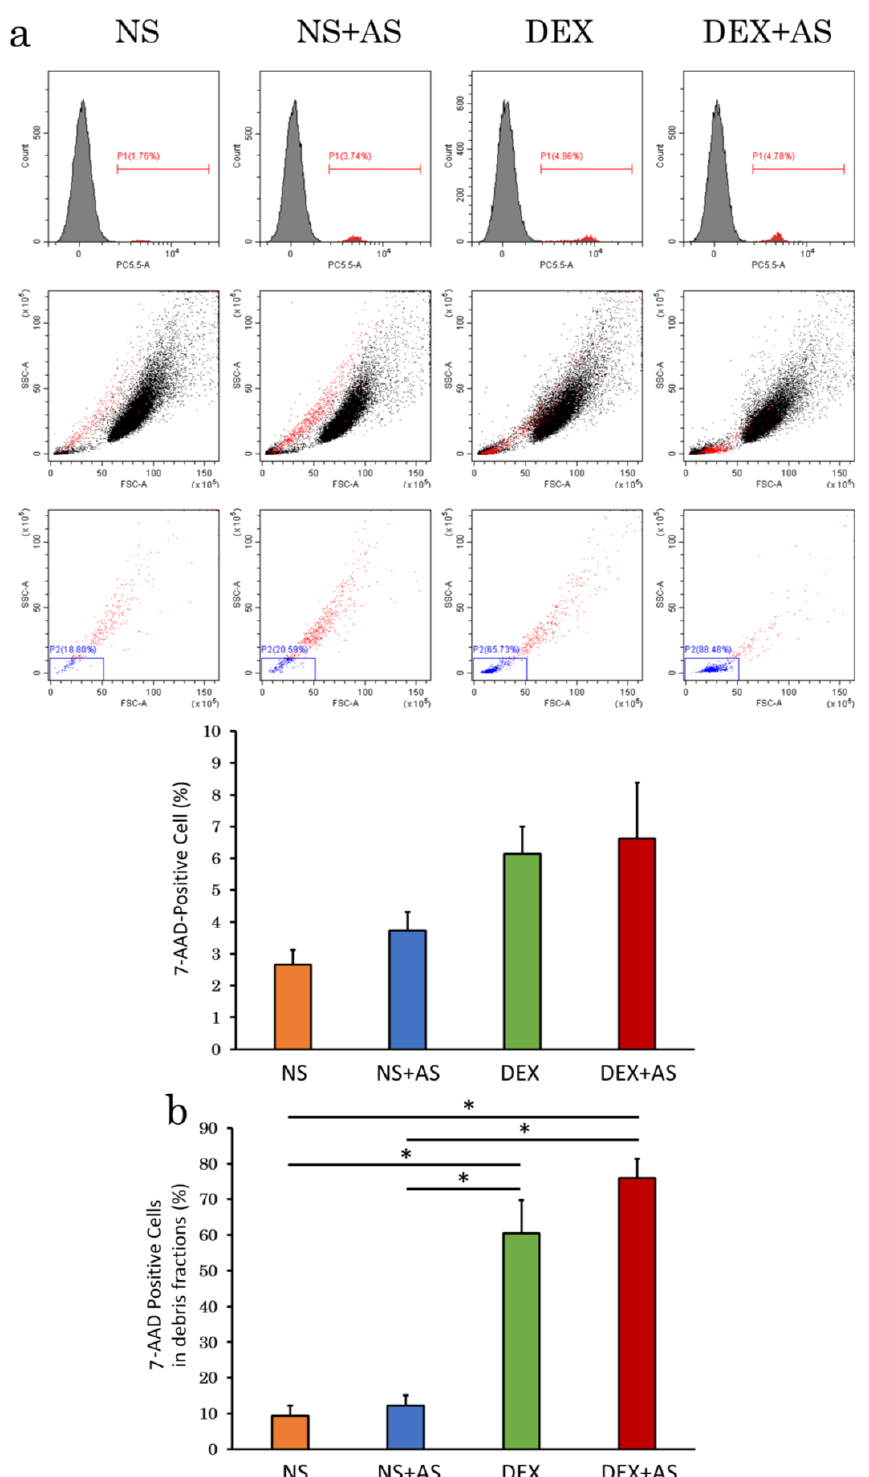
Figure 7. Flow cytometry analysis of dead cells stained with 7-AAD. ( a ), Dot plots and histograms of all analyzed cells ( top and middle rows), and dot plots of 7-AAD-positive cells gated by debris fraction ( lower row). Although there was no significant difference, percentage of 7-AAD-positive cells were lower with NS than with DEX, and without than with AS ( p = 0.05); ( b ), Suspension in DEX significantly increased 7-AAD-positive cells in the debris fraction. * p < 0.01, between groups. NS: normal saline; AS: allogenic serum; DEX: 5%